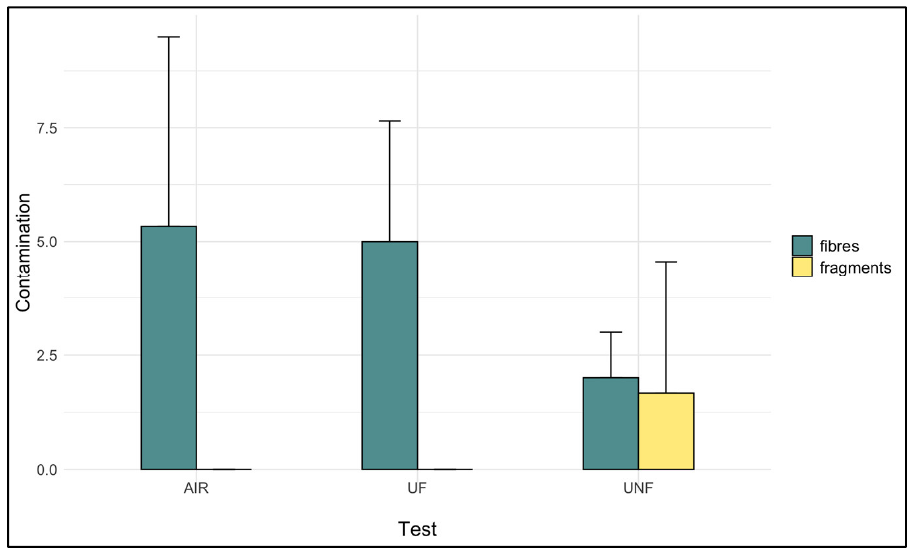
Figure 3. Average number of contamination particles (fibers and fragments) for the different tests performed (i.e., 10 min of air filtration ‘AIR’; 1000 mL of ultrapure water not filtered and filtered) with standard deviation values. ‘AIR’ air evaluation; ‘UF’ Ultrapure water filtered; ‘UNF’ Ultrapure water Not filtered.